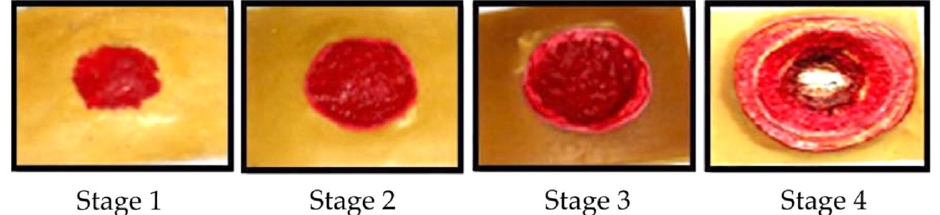
Figure 1. Stages of tissue injuries.